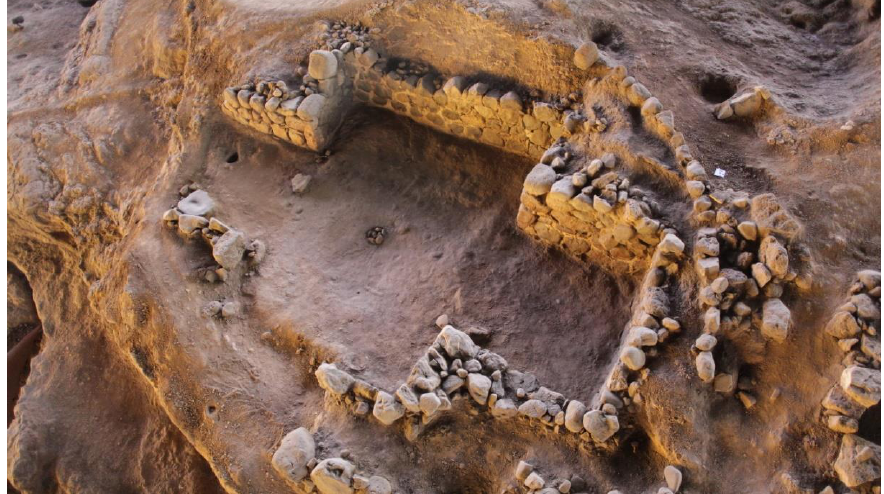
Figure 8. Oblique image acquired from the pole system in order to reconstruct the walls of the remains.